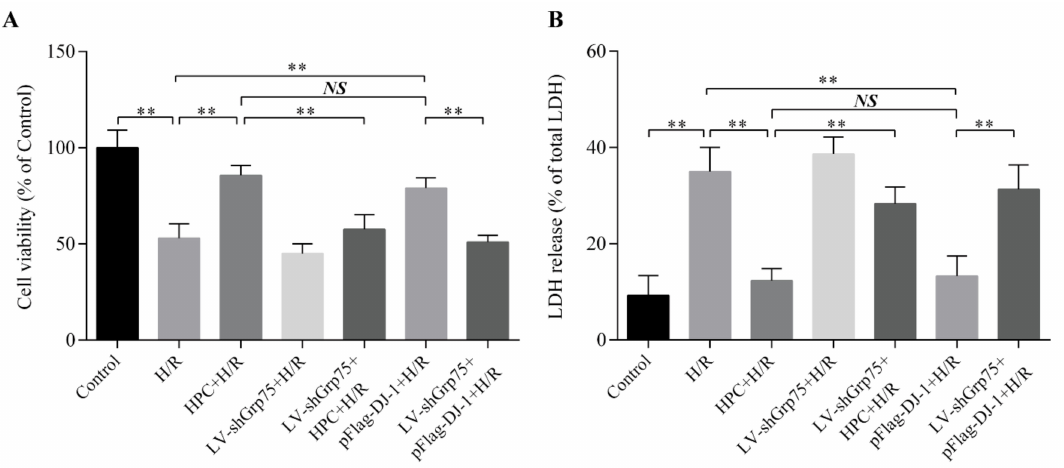
Figure 8. E ff ects of Grp75 knockdown on DJ-1-mediated cardioprotection of hypoxic preconditioning (HPC) in H9c2 cells undergoing hypoxia / reoxygenation (H / R). H9c2 cells were infected by lentiviral (LV) vectors LV-shGrp75 for 72 h and then subjected to HPC 24 h prior to H / R or transfected with pFlag-DJ-1 for 48 h followed by H / R. Subsequently, the cellular damage was analyzed by measuring cell viability ( A ) and lactate dehydrogenase (LDH) release ( B ), as described in Materials and Methods section. Each value represents the mean ± SD of three independent experiments. ** p < 0.01 as indicated on the figure. NS indicates no